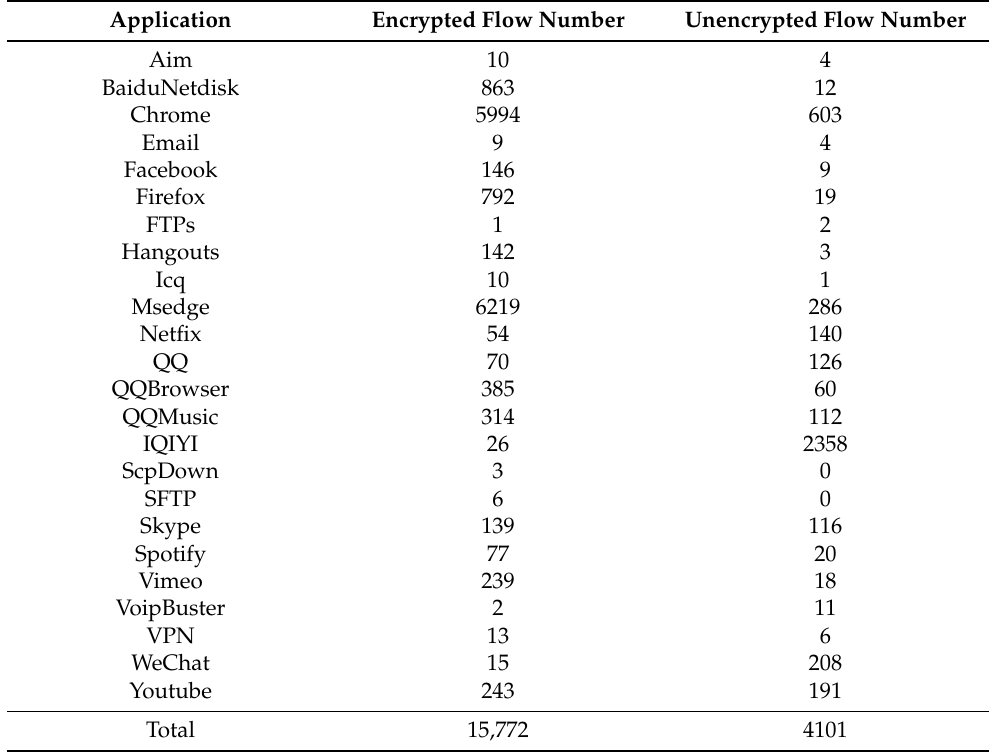
Table 2. Statistic information on the data used in encrypted traffic detection.